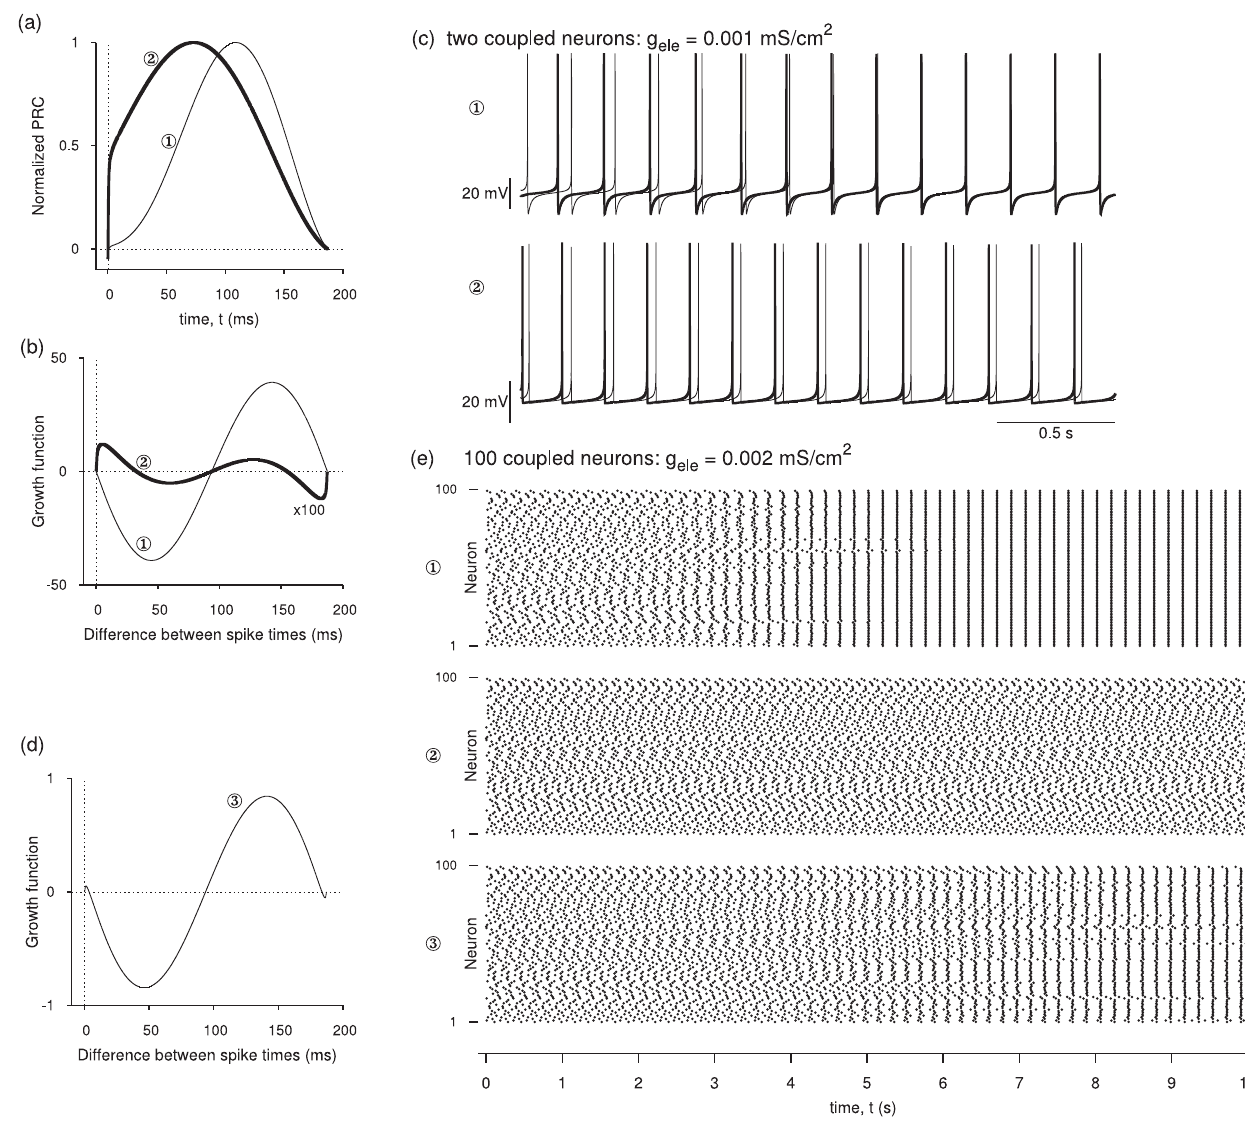
Figure 6. Effect on network behavior emerging from different PRC shapes. Modified Wang and Buzsa´i model neurons are used to compute PRCs at two parameter sets (a) resulting in a PRC that is nearly symmetric, and another that has very steep rise near small phases. (b) Growth functions corresponding to the PRCs in (a). (c) Voltage time courses of two coupled model neurons corresponding to the parameter sets of the two PRCs in (a). (d) Growth function for a third parameter set resulting in a non-zero phase-locked state near synchrony. (e) Spike times (plotted as dots) of a network of 100 all-to-all coupled model neurons for the three parameter sets corresponding to the curves in (b,d). The non-zero phase-locked state near synchrony leads to prolonged transients, and a jitter in the spike times in the steady state. # 1 : w n ~ 2 , I app ~ 0 : 17791 m A/cm 2 . # 2 : w n ~ 9 , I app ~ 0 : 17 m A/cm 2 . # 3 : w n ~ 8 : 3 , I app ~ 0 : 172536 m A/cm 2 . w h is fixed at 5 for all the three sets.